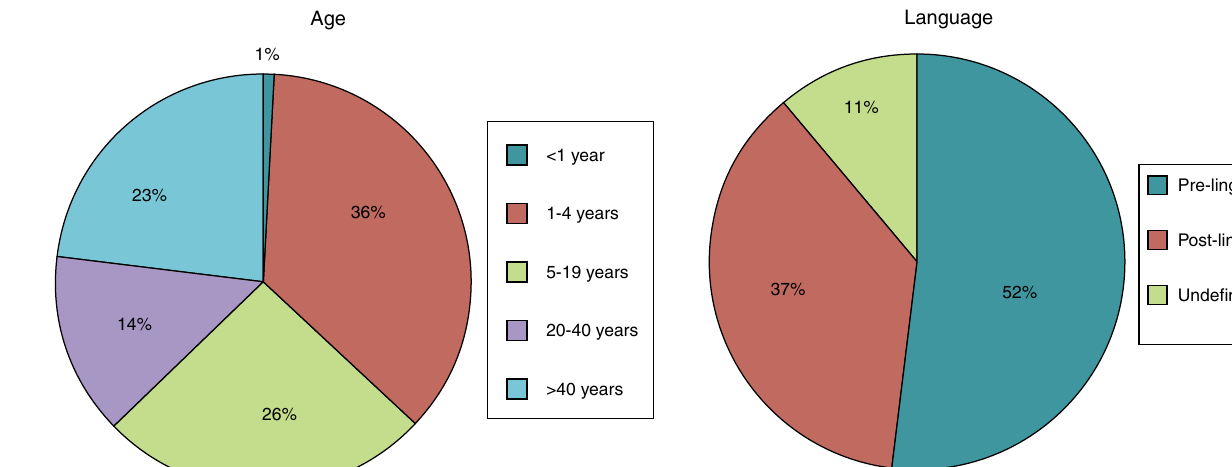
Figure 1 Percentage distribution by age range of patients undergoing evaluation for cochlear implant.